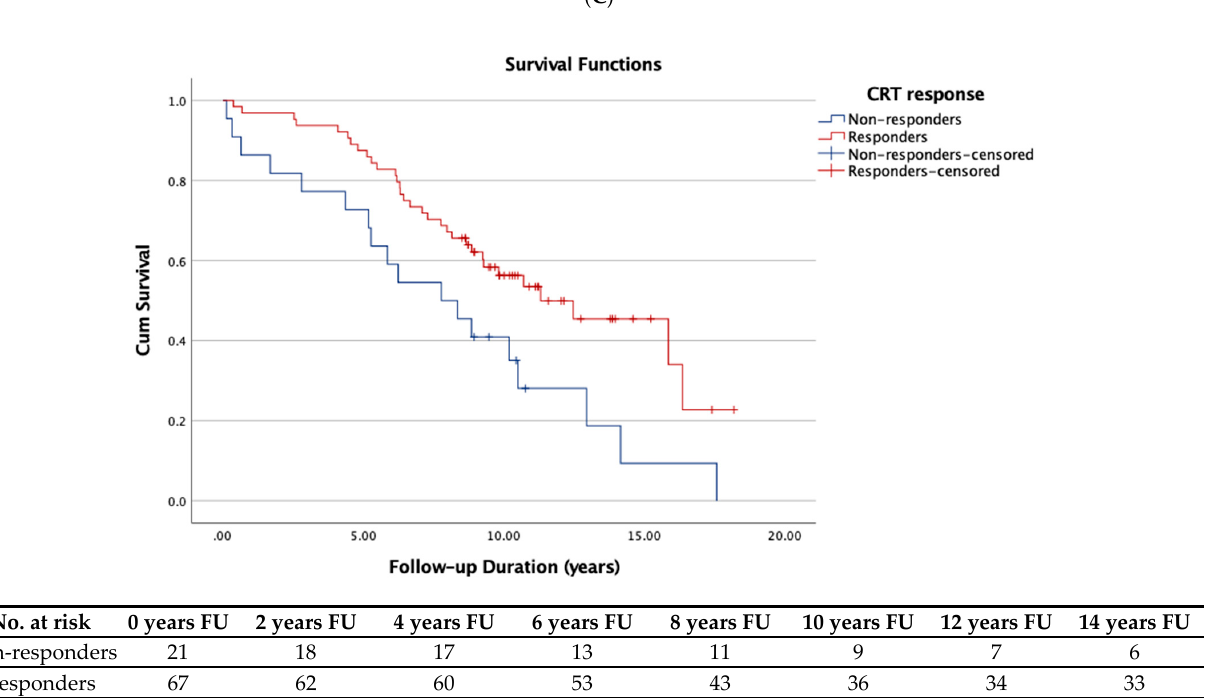
Figure 2. Kaplan–Meier survival functions, with corresponding tables describing the number (N) of patients at risk at a given point of the follow-up, for presence of NICM vs. ICM (Panel A ); patients with NYHA III vs. NYHA IV at the time of implantation (Panel B ). Patients with upper vs. lower median of QRS width during biventricular pacing (Panel C ), as well as clinical responders to CRT therapy vs. non-responders to CRT therapy (Panel D ). (NICM: non-ischemic cardiomyopathy; NYHA: New York Heart Association; BIV: biventricular pacing; ICM: ischemic cardiomyopathy; Cum survival: cumulative survival; ms: milliseconds; CRT: cardiac resynchronization therapy).